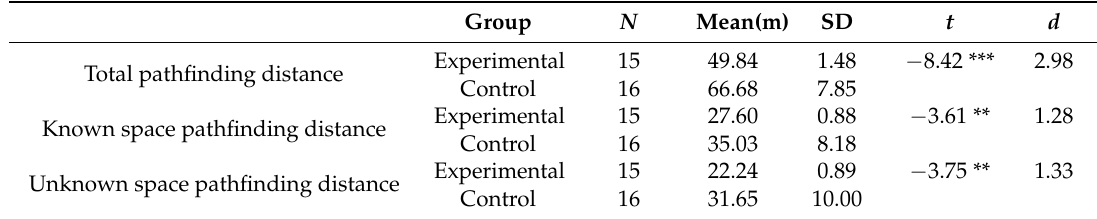
Table 4. Independent sample t -test of traveled distance between the two groups. Group Total pathfinding distance Known space pathfinding